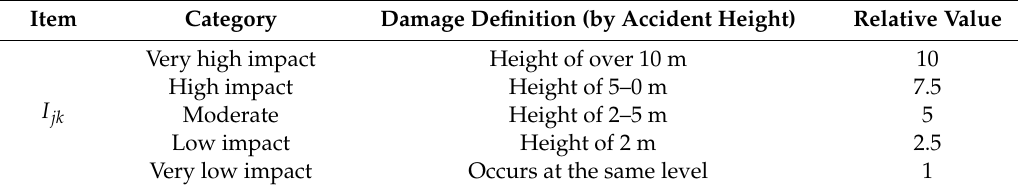
Table 8. Structural risk damage definition and relative values.